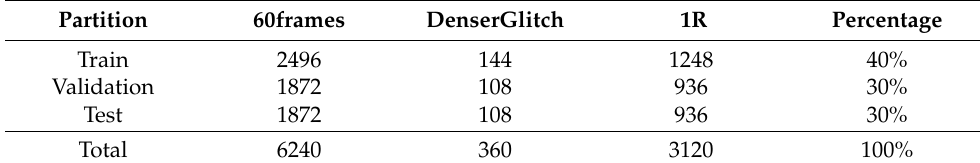
Table 2. Amount of instances per partition for each of the produced